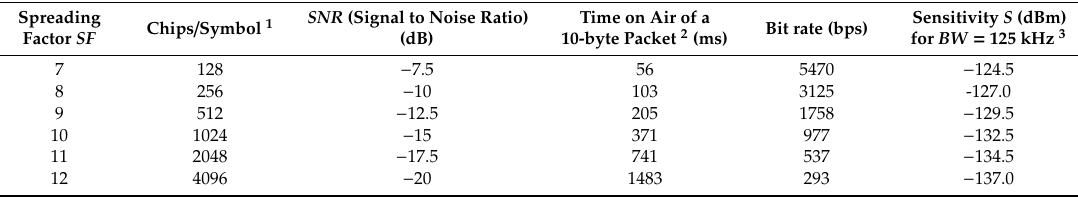
Table 3. Parameters as a function of the Spreading